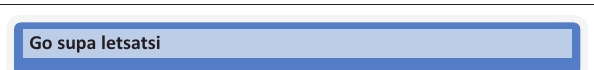
FIGURE 10: Maele (Idioms [Figures 9–12]).